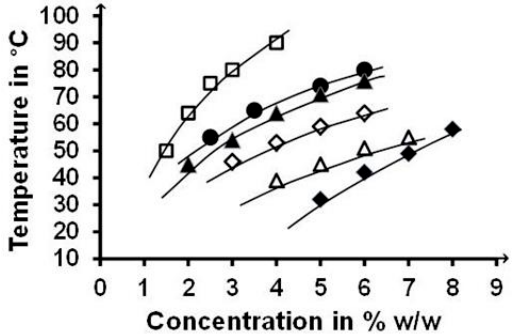
Figure 8. Gel → sol transition temperatures of PNAGA- co -NA L ALA of different compositions synthesized using different concentrations of transfer agent in the feed: □ Cop75 0.25 ; ● Cop50 0.1 ; ▲ Cop50 0.25 ; ♦ Cop50 1 ; ◊ Cop25 0.25 ; ∆ Cop10 1 . Differences between replicates are inside the size of data points.